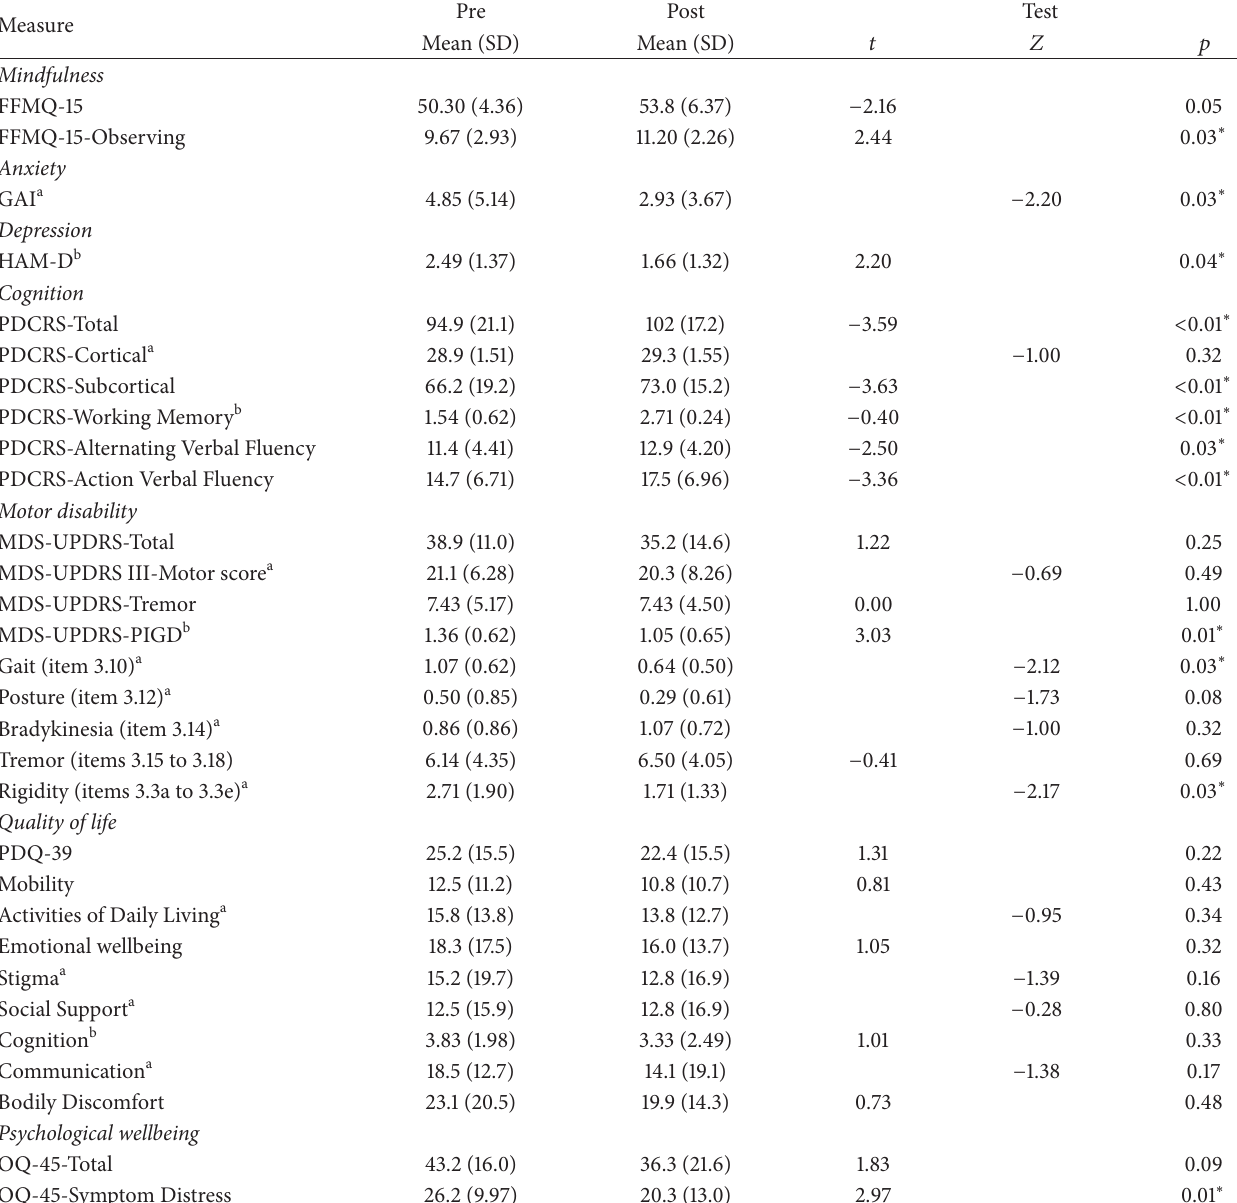
Table 1: A comparison of outcome measures between baseline (pre-) and